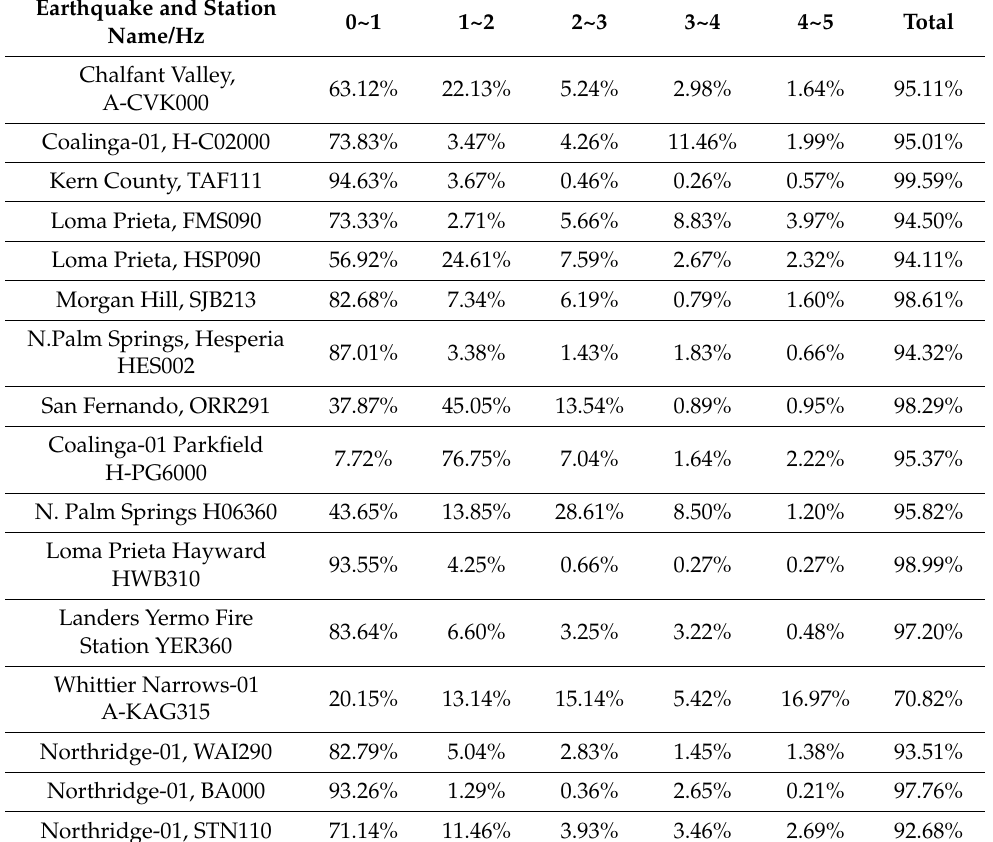
Table 2. Energy distribution of far-field earthquakes.